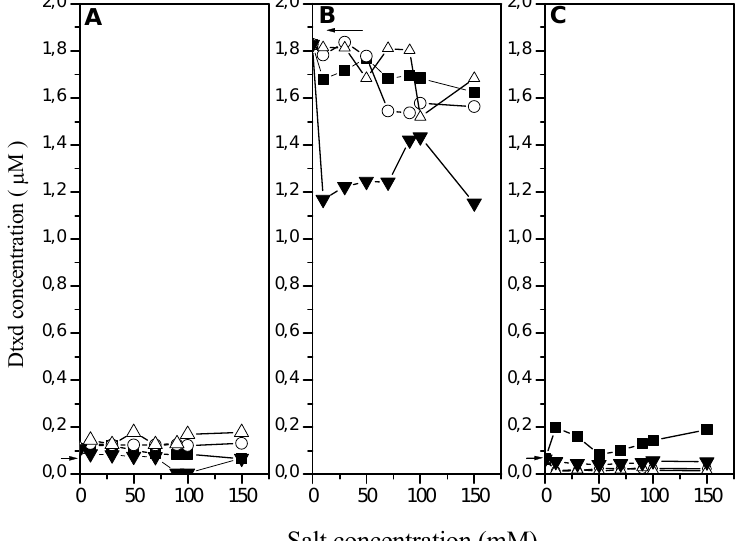
( ▼ ) were added to the 2 Cl at 24,000 rpm. The 2 2